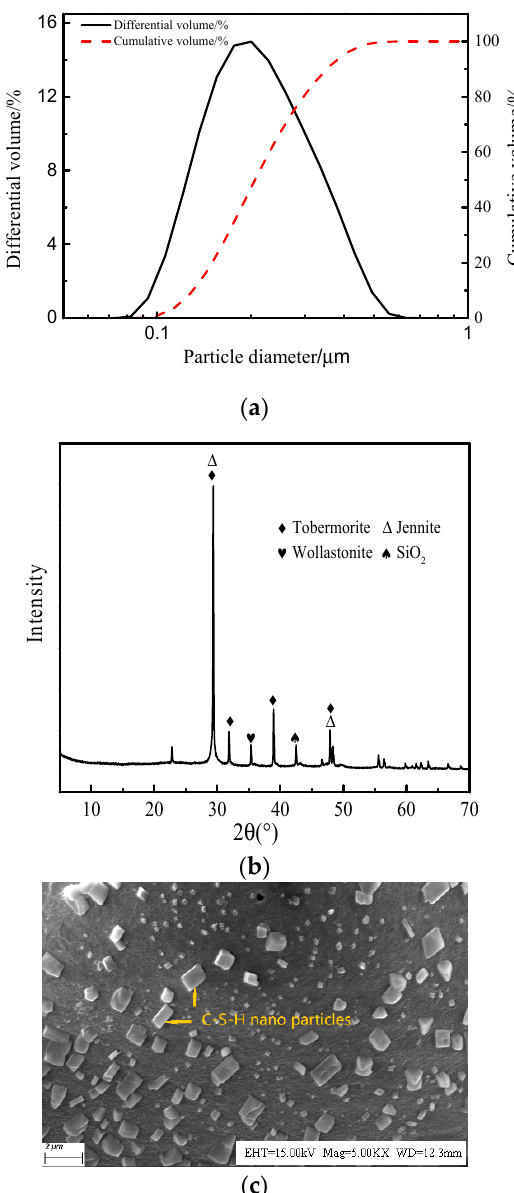
Figure 2. ( a ) Particle distribution of synthesized nano C-S-H particles; ( b ) XRD pattern of the synthesized nano C-S-H particles; ( c ) SEM image of synthesized nano C-S-H particles.